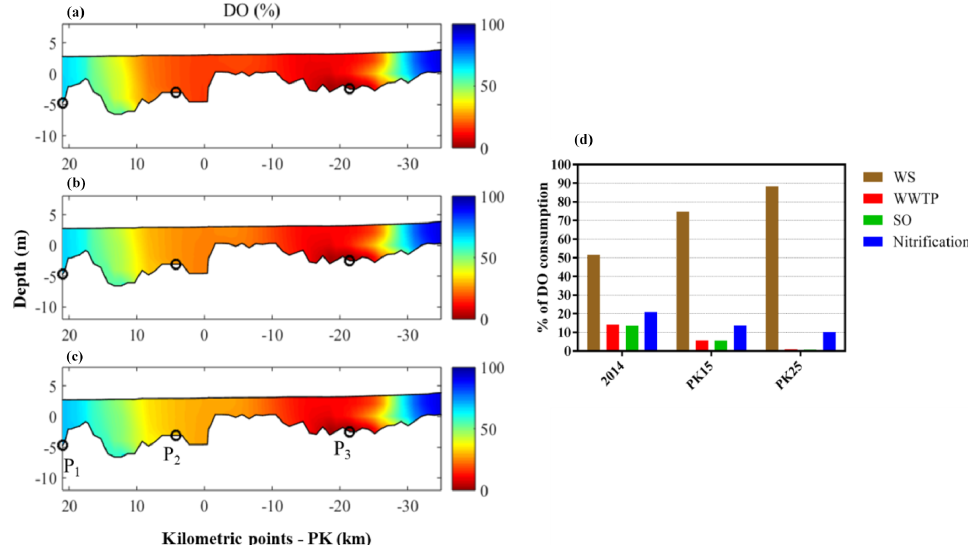
Figure 3. Snapshot of the vertical transect of simulated DO saturation along the tidal Garonne river for the scenarios with urban effluent discharge points in Bordeaux (a) , KP15 (b) and KP25 (c) . P1, P2 and P3 indicate the locations of Bec d’Ambès, Bordeaux and Portets, respectively. The contribution to DO consumption (%) of degradation of watershed (brown), WWTP (red), SO (green) and nitrification (blue) processes at Bordeaux (d) . For nitrification processes, ammonium comes from watershed and wastewater.